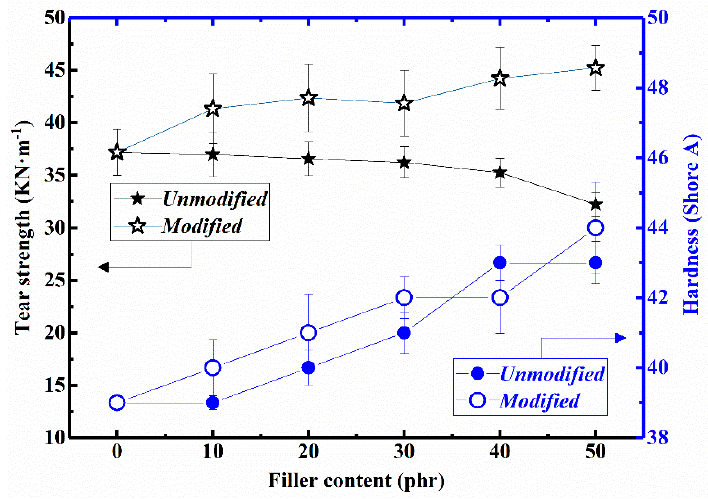
Figure 9. The influence of filler content on tear strength and hardness of the FD/NR and mFD/NR composites.